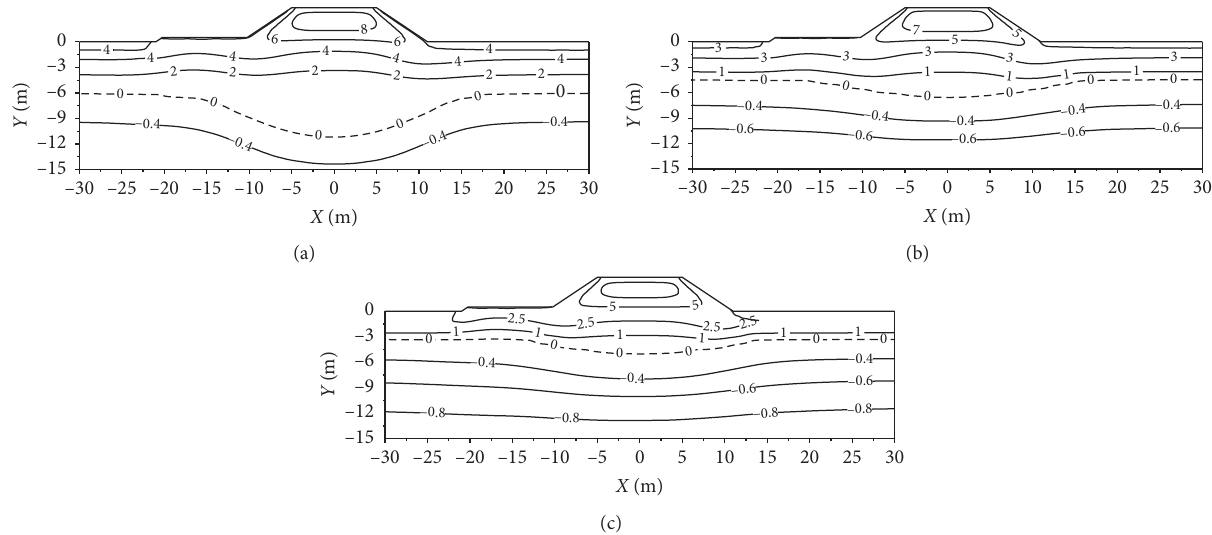
Figure 8: Distribution of the temperature field beneath the SE in October of the 50th year under the different mean annual ground temperatures: (a) − 0.5 ° C, (b) − 1.0 ° C, and (c) − 1.5 ° C (unit: ° C).